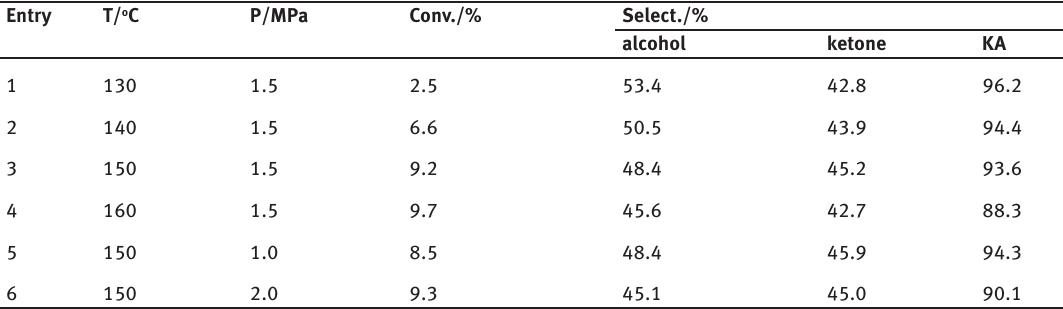
Table 4: Effect of temperature and pressure on the oxidation of cyclohexane a .